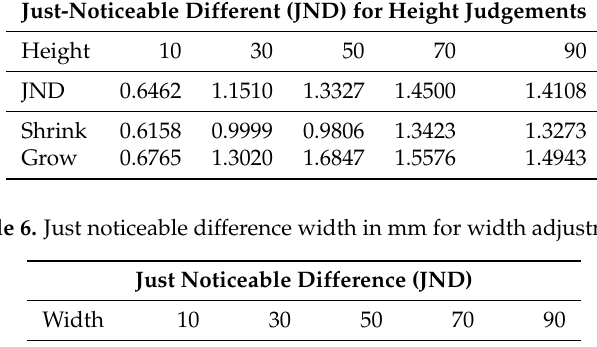
Table 5. Just noticeable difference height in mm for height judgements.